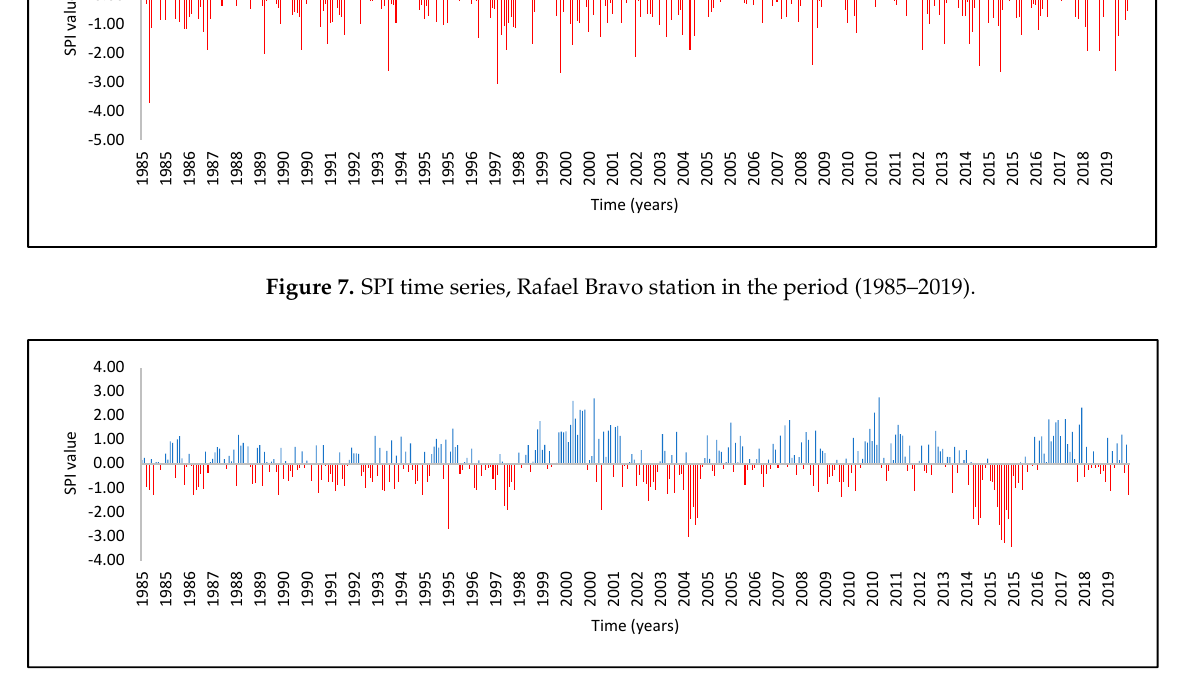
Figure 8. SPI time series, Primate station in the period (1985–2019).